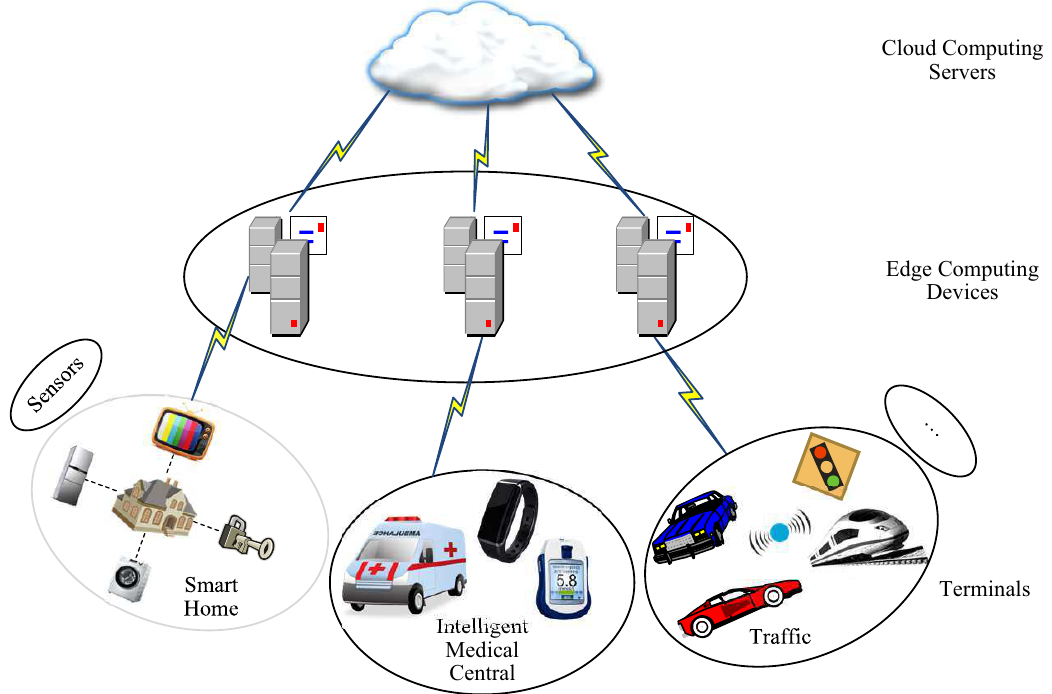
Figure 1. A simplified model of edge computing system.The edge computing system consists of edge computing devices who are usually specific high-end servers with powerful central processing unit, larger memory and storage, and various terminals that usually have limited resources [3] (such as limited computation power, battery, memory and